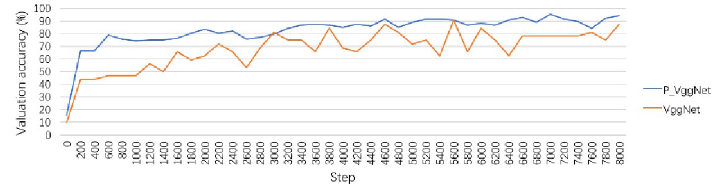
Fig 5. Validation accuracy curve of P_VggNet and